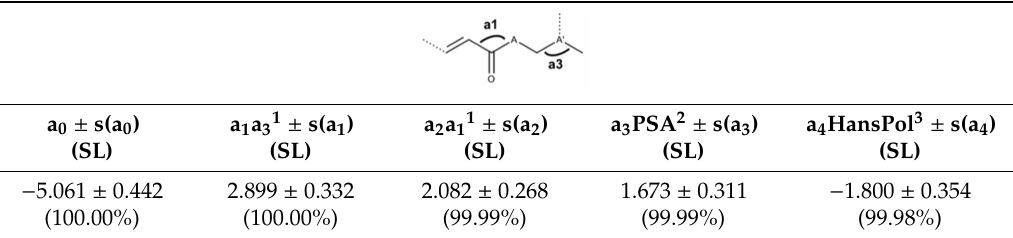
Table 2. Best model found by MLR analysis: pMIC = a 0 + a 1 a3 + a 2 a1 + a 3 PSA + a 4 HansPol . Molecular descriptors are in bold, and values in parenthesis correspond to the significance level of each adjusted parameter. All descriptors were normalized.